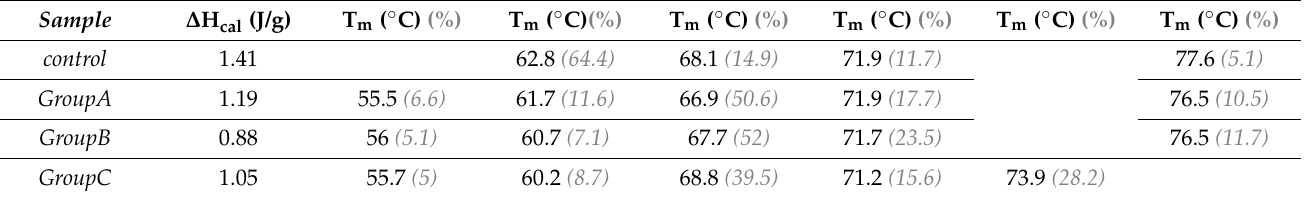
Figure 1. Denaturation scans of blood plasma (data were applied from our previous studies) [33,36,37] ( A , C , E , G ) and their deconvolution ( B , D , F , H ) from control patients ( n = 10) and with breast tumor ( n = 19), classified by different number of affected lymph nodes (see text). Table 1. Contribution of deconvolved transitions from Figure 1 to the total calorimetric enthalpy, gray numbers infers the relative participation to the total change (based on instrument error, only those compounds are used which have a higher than 5% change, recently